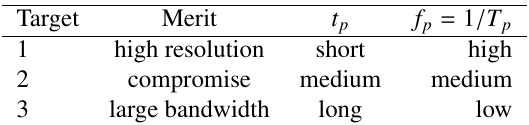
Table 1. Comparative proton pulse sequences for three target stations at HBS.